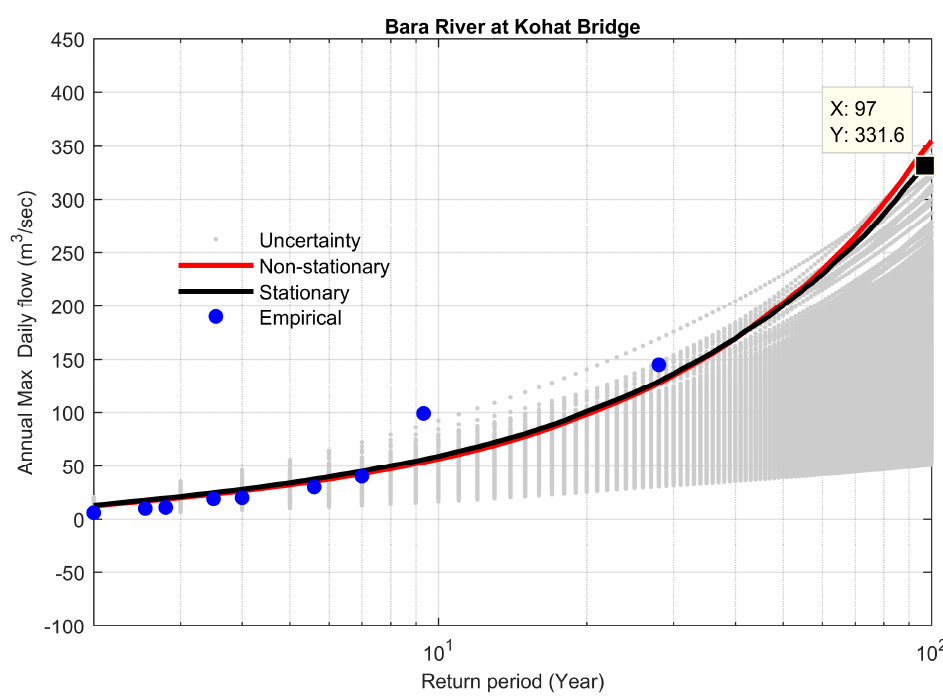
Figure 22. Comparison between non-stationary and stationary FFCs at site 24, along with non-stationary uncertainty bounds for the year 2009.